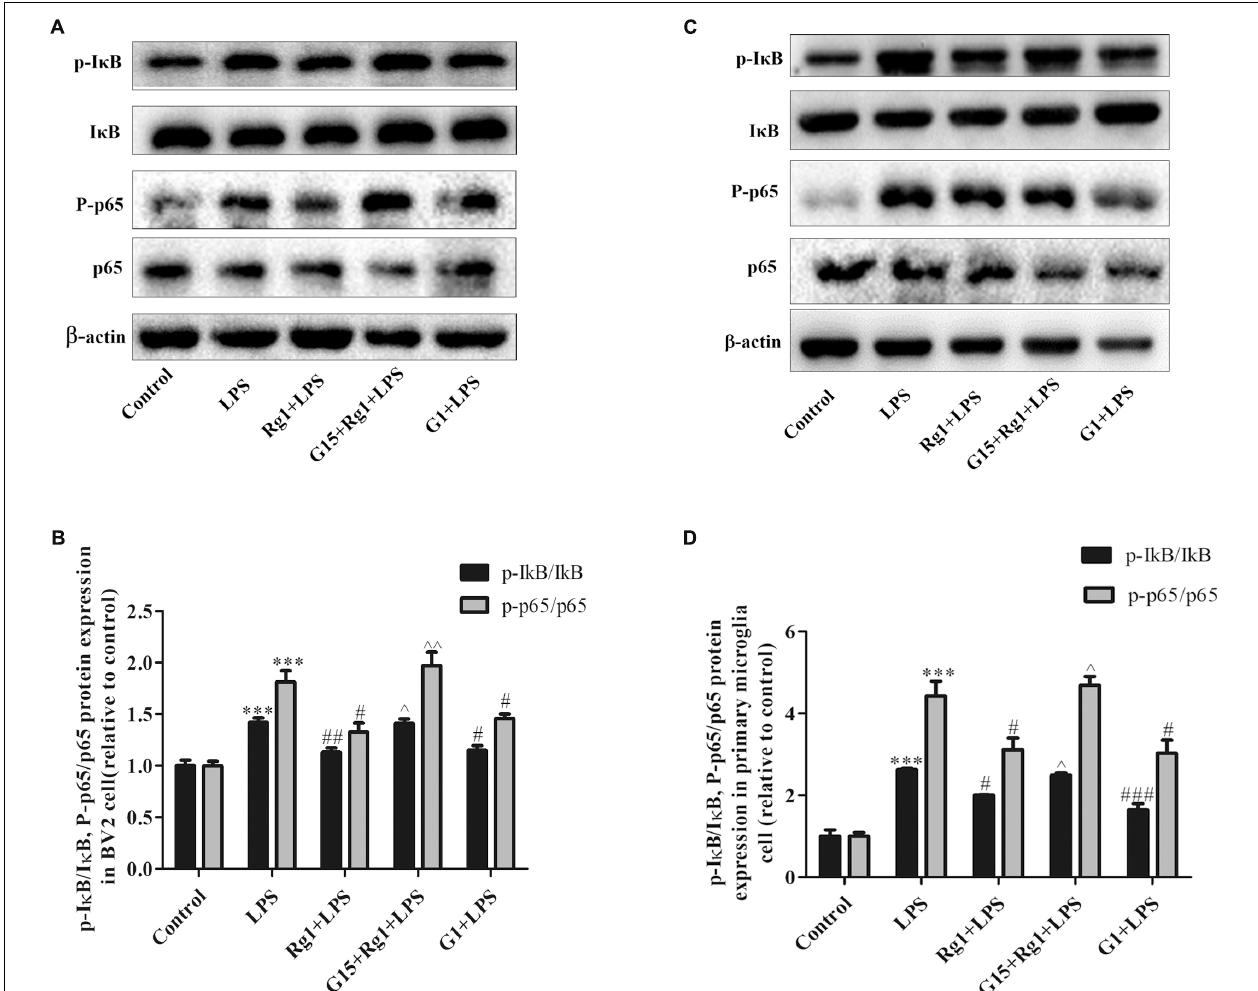
FIGURE 5 | G15 blocked the inhibitory effect of Rg1 on LPS-induced activation of nuclear transcription factor-kappa B (NF- κ B) signaling pathway. BV2 cells and primary microglia were incubated in Dulbecco’s modified Eagle’s medium (DMEM)-H without FBS for 4 h, pretreated with 1 µ M G15 for 1 h, followed by 10 µ M Rg1 or 1 µ M G1 for 1 h, and stimulated with LPS (BV2 cells: 1 µ g ml − 1 ; primary microglia: 0.5 µ g ml − 1 ) for 0.5 h. The phosphorylation levels of inhibitor of NF- κ B (I κ B) and p65 were detected by western blot in BV2 cells (A,B) and primary microglia (C,D) . Results are expressed as the mean ± SEM, n = 3. ∗∗∗ P < 0.001 versus control; # P < 0.05, ## P < 0.01, and ### P < 0.001 versus the LPS group; ∧ P < 0.05 and ∧∧ P < 0.01 versus the Rg1 + LPS